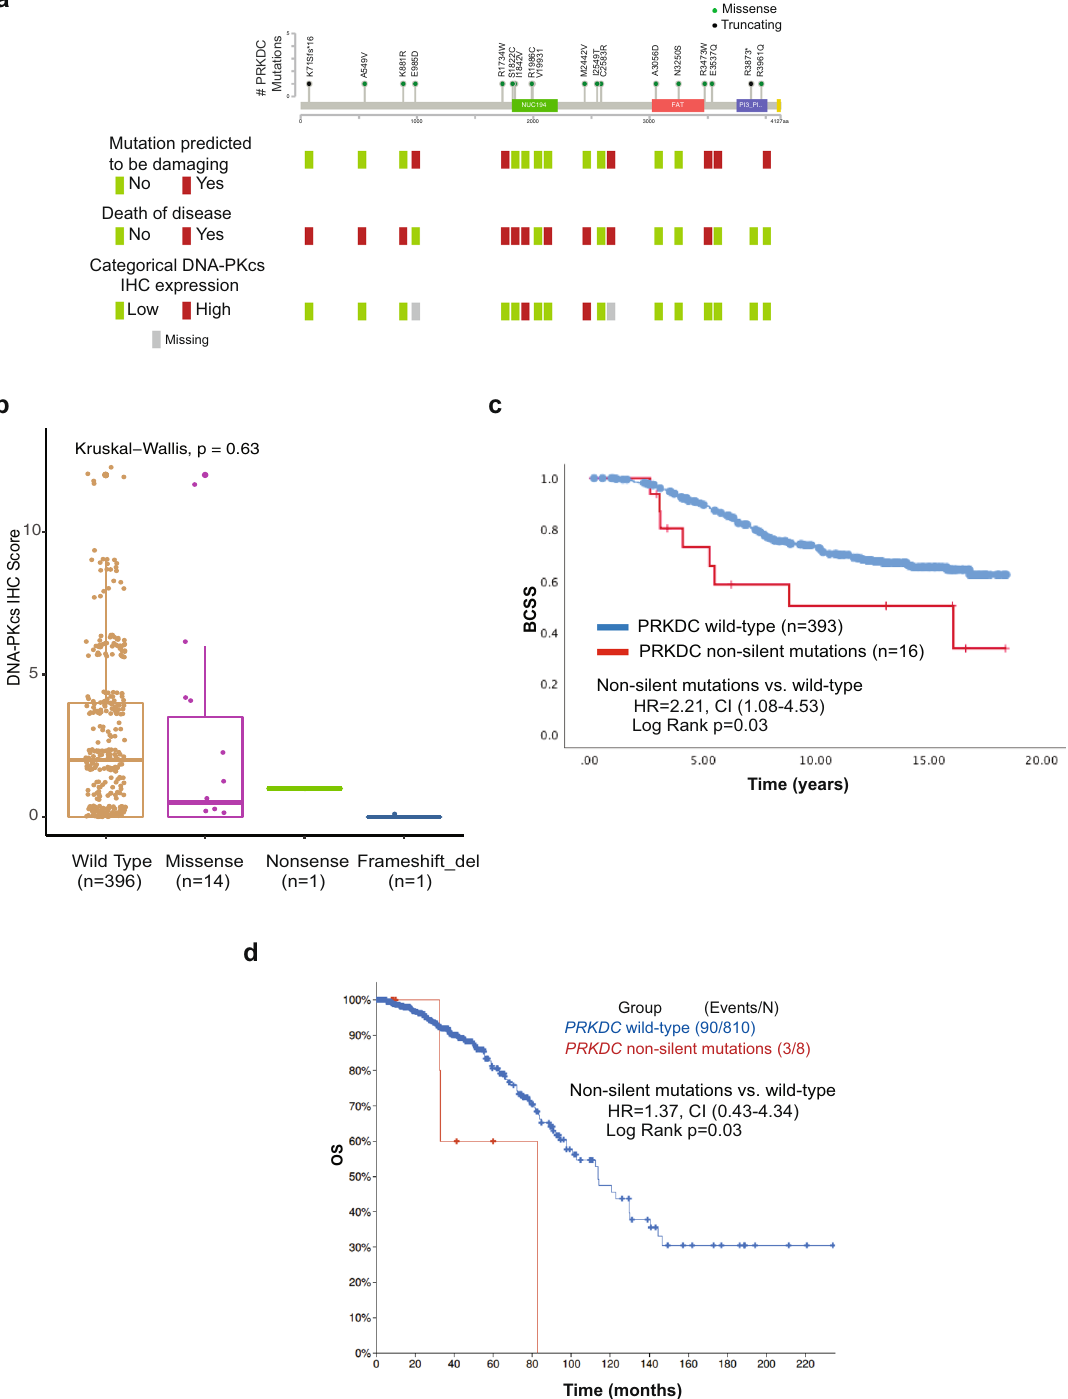
Fig. 7 PRKDC non-silent somatic mutations are associated with poor clinical outcomes. a Lollipop plot for PRKDC mutations identi fi ed in a set of 640 tamoxifen-treated, clinically ER + patients. Green- fi lled circles denote missense mutation and black- fi lled circles denote truncating mutations. Protein domains are indicated as follows: green, NUC194 domain B in the catalytic subunit of DNA-dependent protein kinases; red, FAT domain present in the PIK-related kinases; dark-blue, Phosphoinositide 3-kinase (PI3K) domain. A complete description of PRKDC mutations has been previously published and can be found in Supplementary data 3 of Grif fi th et al. 42 . Mutation pathogenicity, clinical annotation of death due to disease, and DNA-PKcs expression categories by IHC for the corresponding cases are displayed. b Boxplots showing the expression levels of DNA-PKcs by IHC according to mutation status and its type. The median (center bar), and the third and fi rst quartiles (upper and lower edges, respectively) are shown. c Kaplan – Meier curve for BCSS in the subgroup of ER + cases treated with tamoxifen in the BC Cancer series according to PRKDC mutation status ( n = 409). d Kaplan – Meier curves for OS in the TCGA cohort of invasive breast cancer according to PRKDC mutation status ( n = 818). Abbreviations: ER estrogen receptor, BCSS breast cancer-speci fi c survival, OS overall survival, IHC